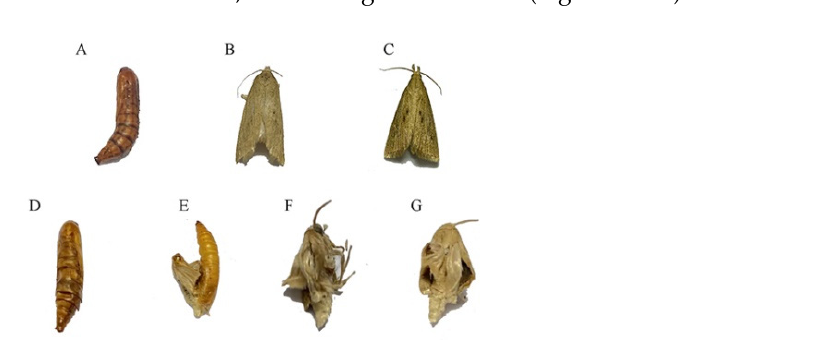
Figure 1. Various phenotypes of the C. suppressalis from pupa to adult. ( A ) normal pupa; ( B ) normal female; ( C ) normal male; ( D ) unable to eclose; ( E – G ) failure of eclosion.